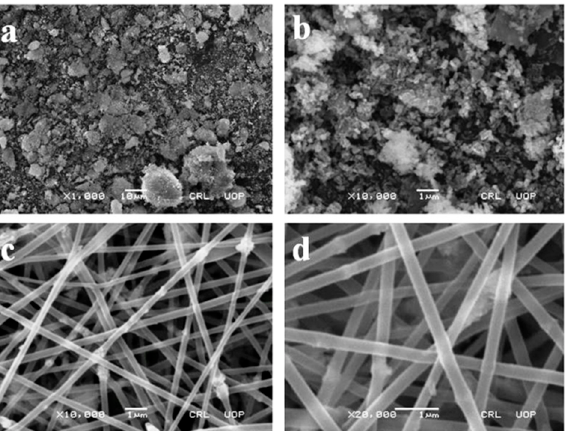
Figure 2. SEM images of the ZnO ( a ) nanoparticles at 10 µm, ( b ) nanoparticles at 1 µm, ( c ) nanofibers at 10 µm, and ( d ) nanofibers at 1 µm.